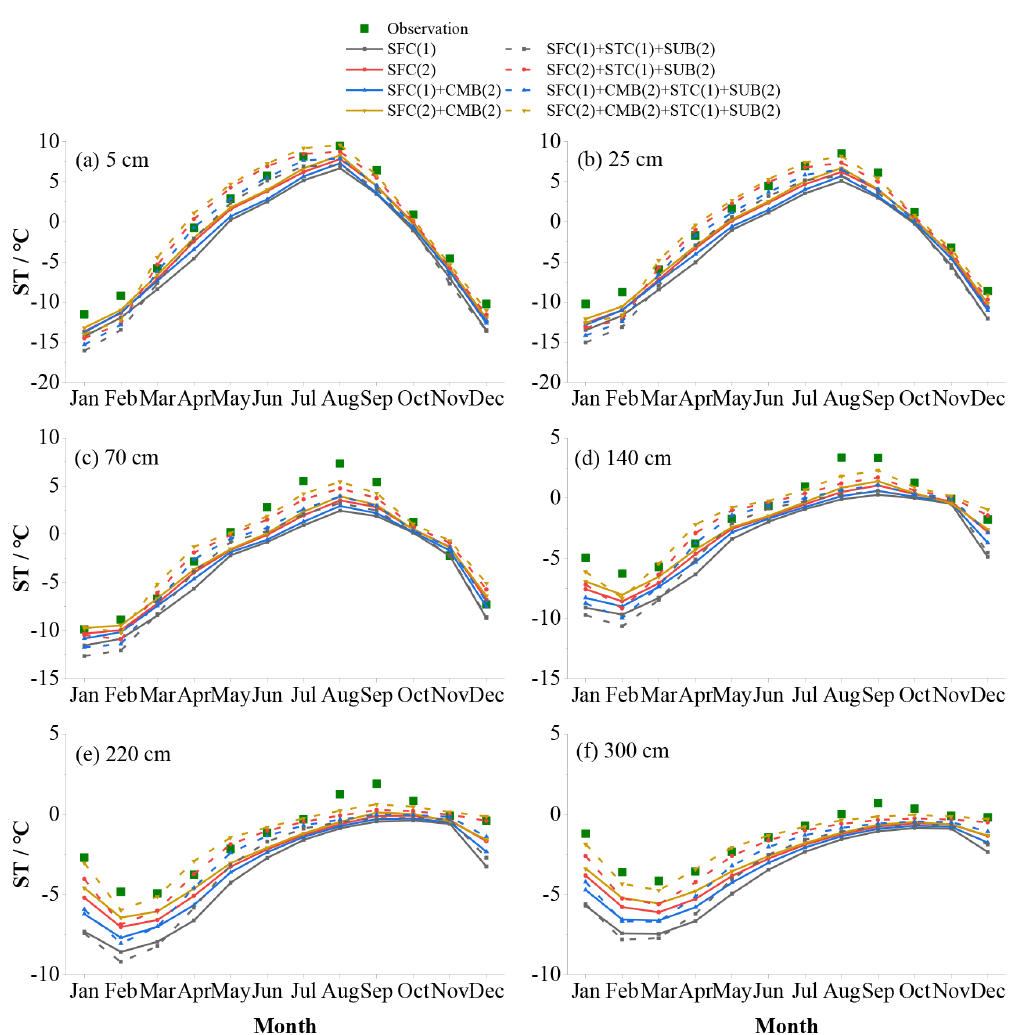
Figure 10. Monthly soil temperature (ST, in ◦ C) at (a) 5cm, (b) 25cm, (c) 70cm, (d) 140cm, (e) 220cm and (f) 300cm for the SFC process with or without consideration of the CMB(2) and STC(1) + SUB(2)